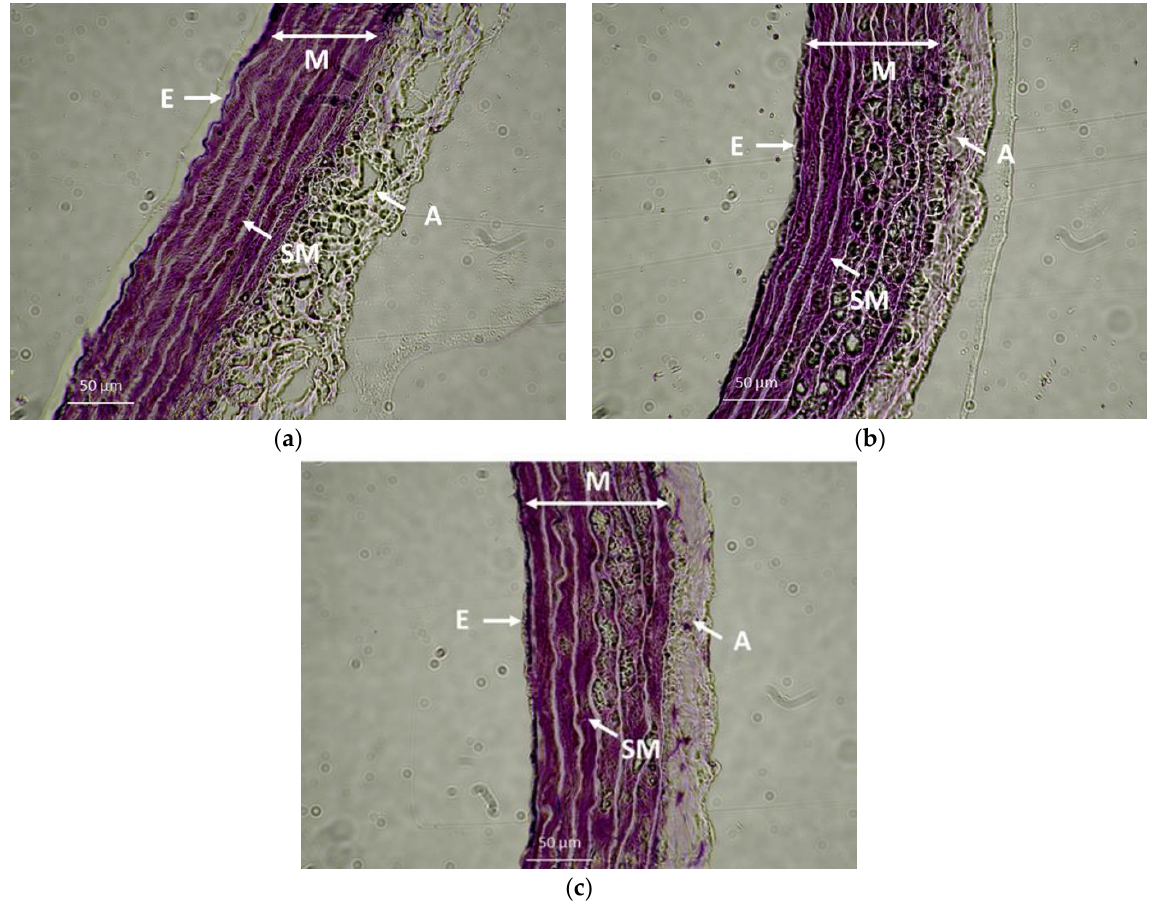
Figure 12. The wall of the thoracic aorta isolated from spontaneously hypertensive rats (SHR) ( a ), SHRs treated with fructose (SHR+FRU) ( b ) and SHRs treated with fructose and GYY-4137 (SHR+FRU+GYY) ( c ). The 5 µm thick cryosections were stained with methylen blue and displayed using optical microscope (40× magnification). E — layer of endothelial cells, SM — layer of smooth muscles, A — adventitia, M — media.